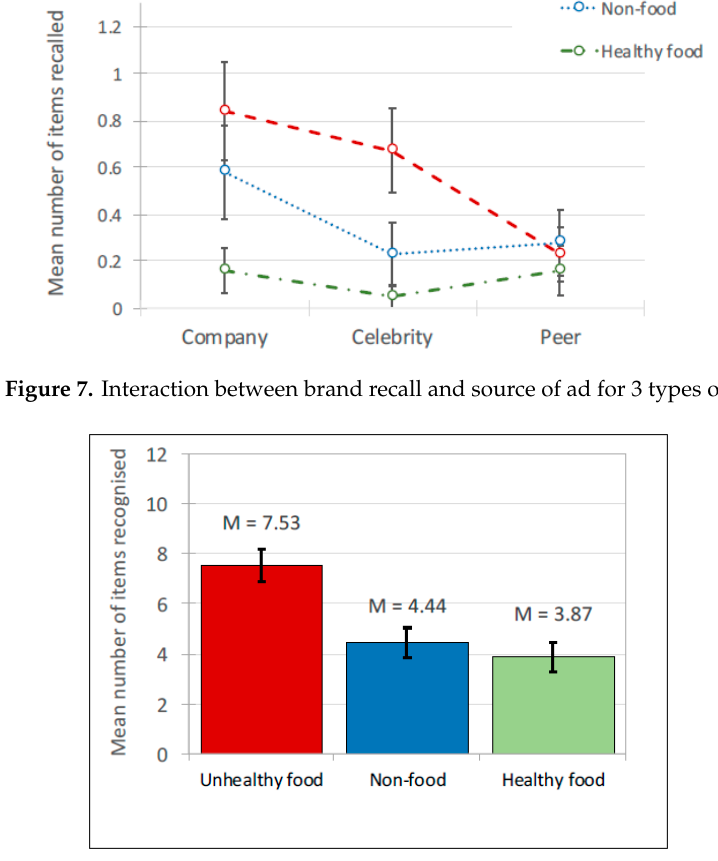
Figure 8. Prompted brand recognition: Mean scores.